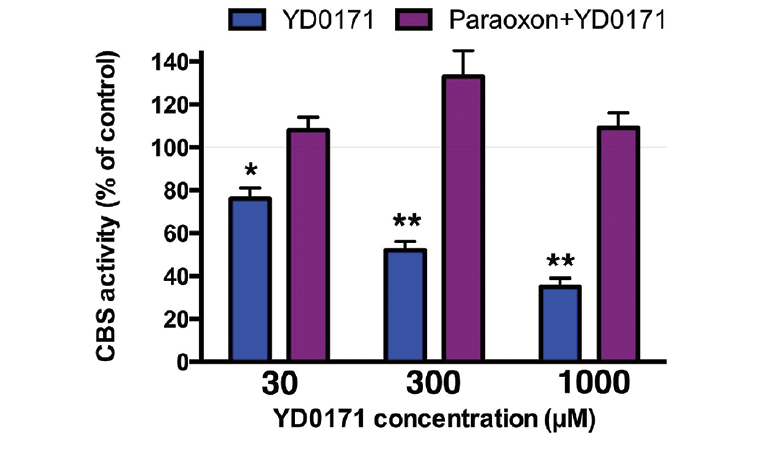
S-synthesizing activity of HCT116 cell 2 S production (detected by the AzMC 2